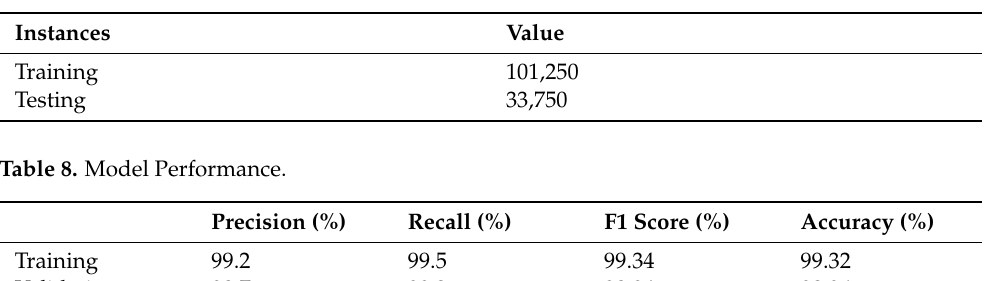
Table 7. Dataset Distribution.